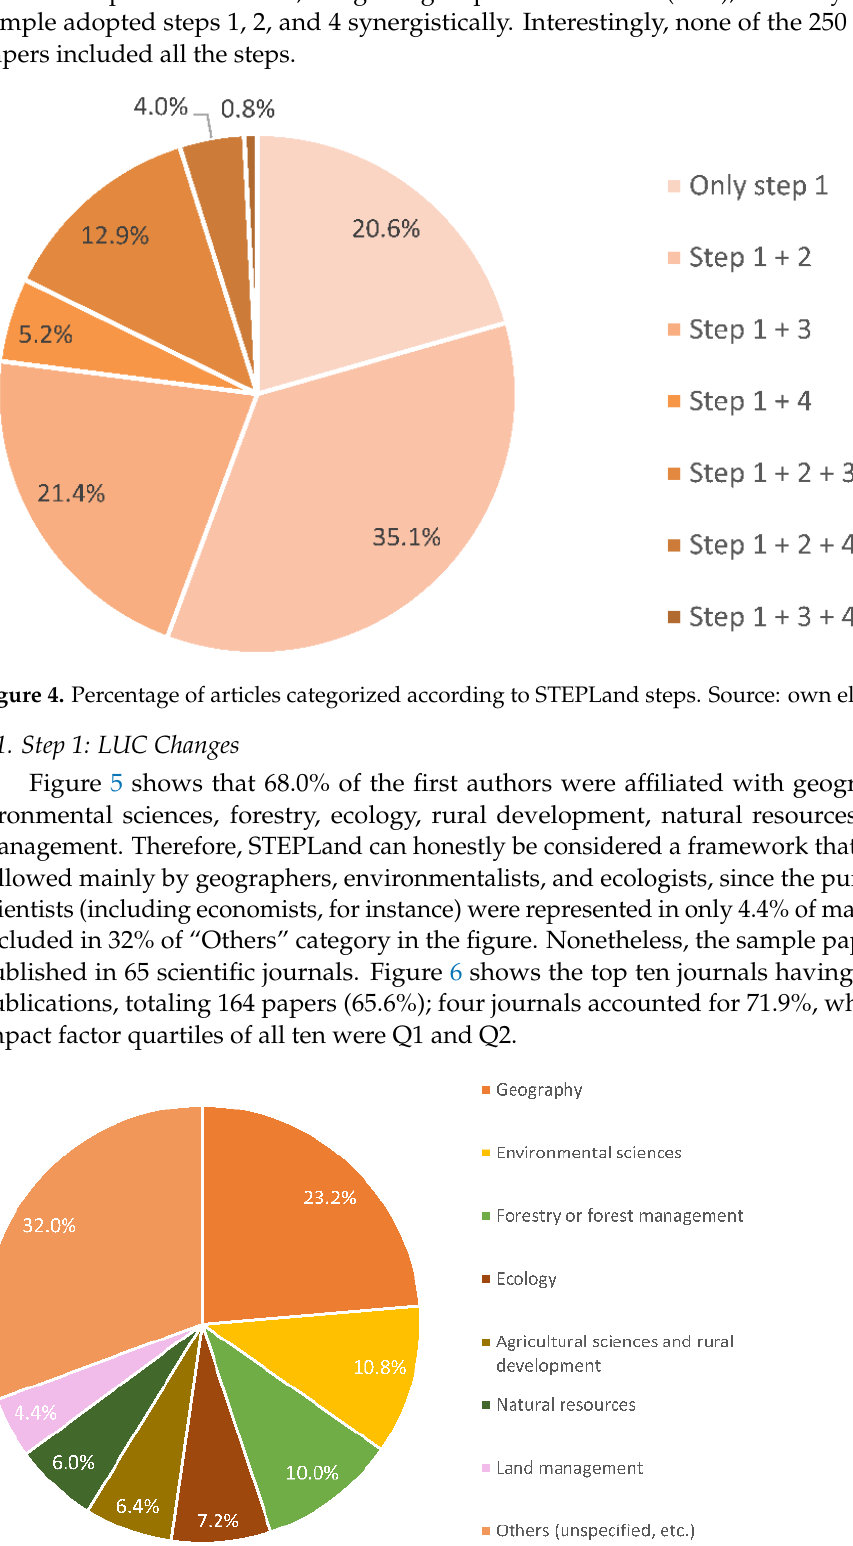
Figure 5. Affiliation discipline of the first author from all papers. Source: own